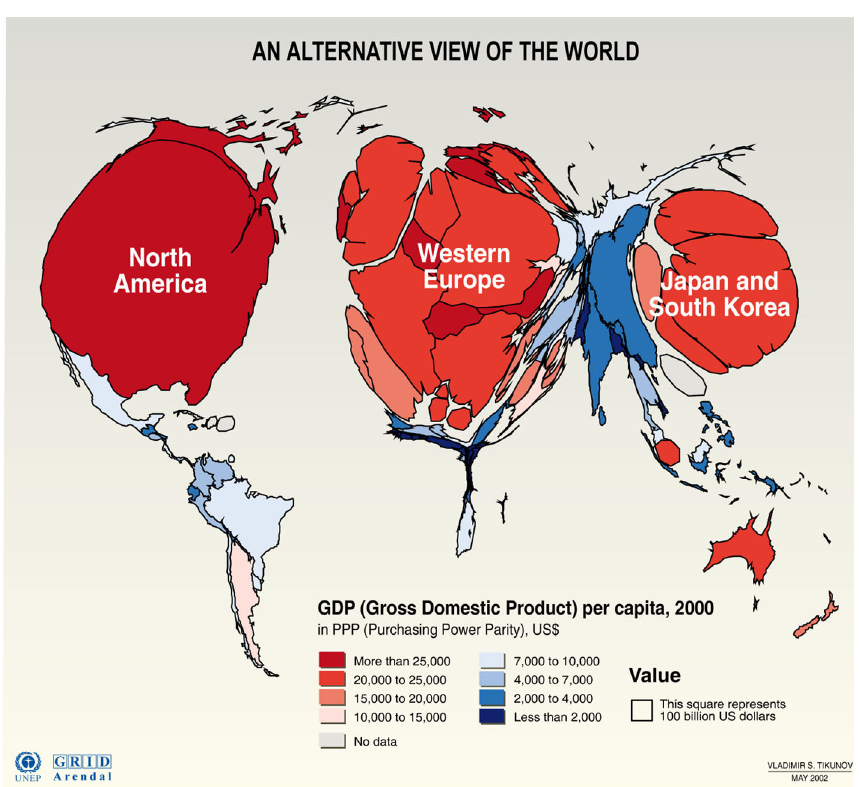
Fig. 2. – The GDP per capita of different regions of the world in Purchasing Power Parity (PPP) in the year 2000